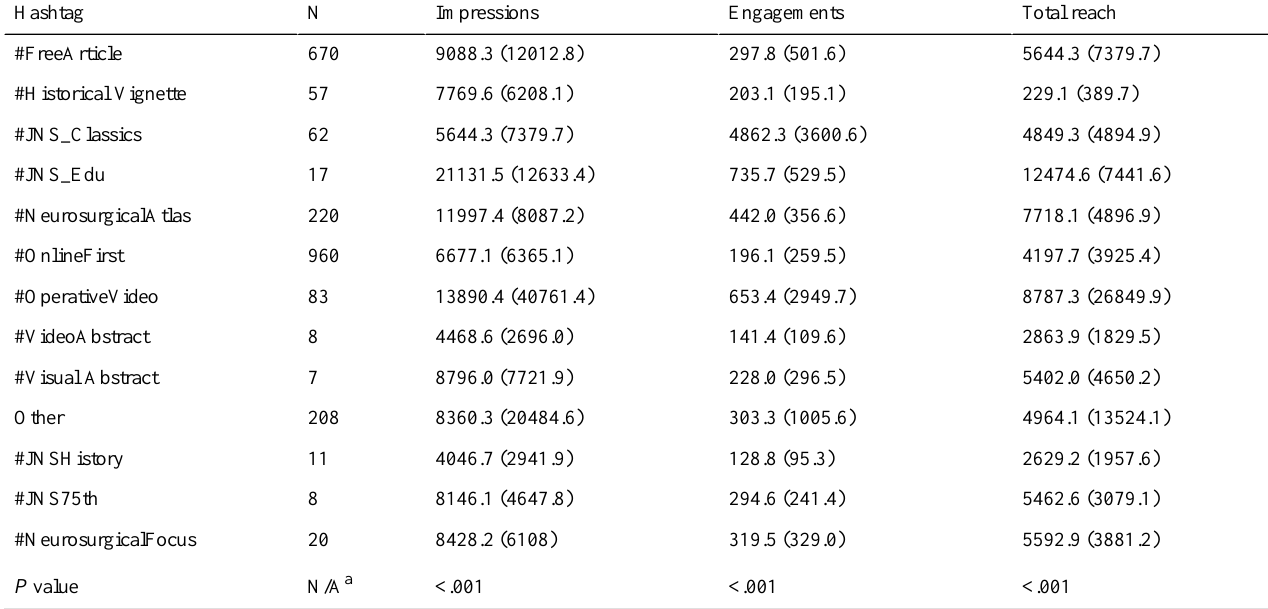
Table 5. Facebook post analytics, mean (SD), by hashtag.